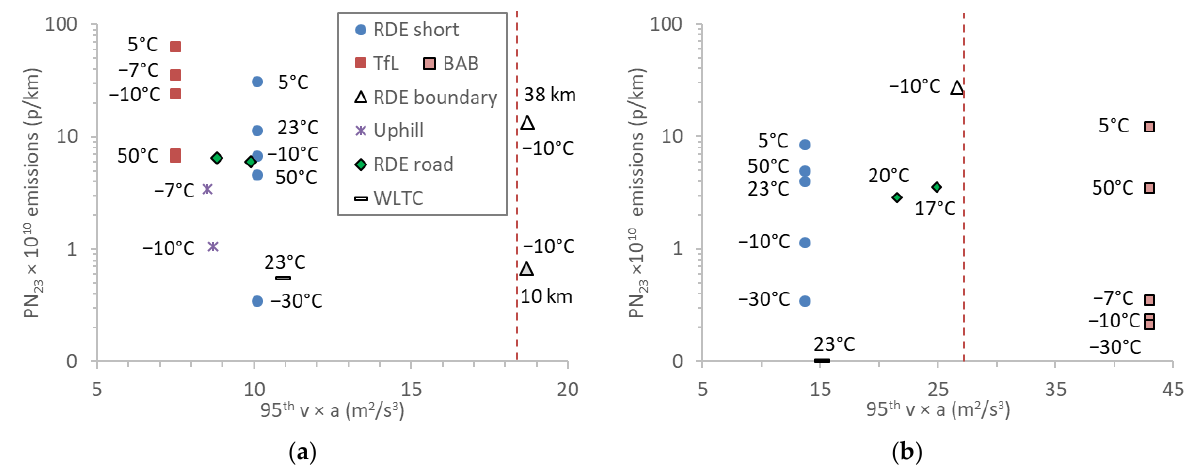
Figure 7. Particle number (PN) emissions > 23 nm in function of dynamicity expressed as 95th percentile of v × a of ( a ) urban cycles (TfL, Uphill) or urban parts of the rest cycles (RDE short, RDE boundary, RDE road, WLTC); ( b ) motorway cycle (BAB) or motorway parts of the rest cycles (RDE short, RDE boundary, RDE road, WLTC). Dashed lines show approximate dynamicity limits which depend on the mean speed. RDE = real-driving emissions; WLTC = worldwide harmonized light vehicles test